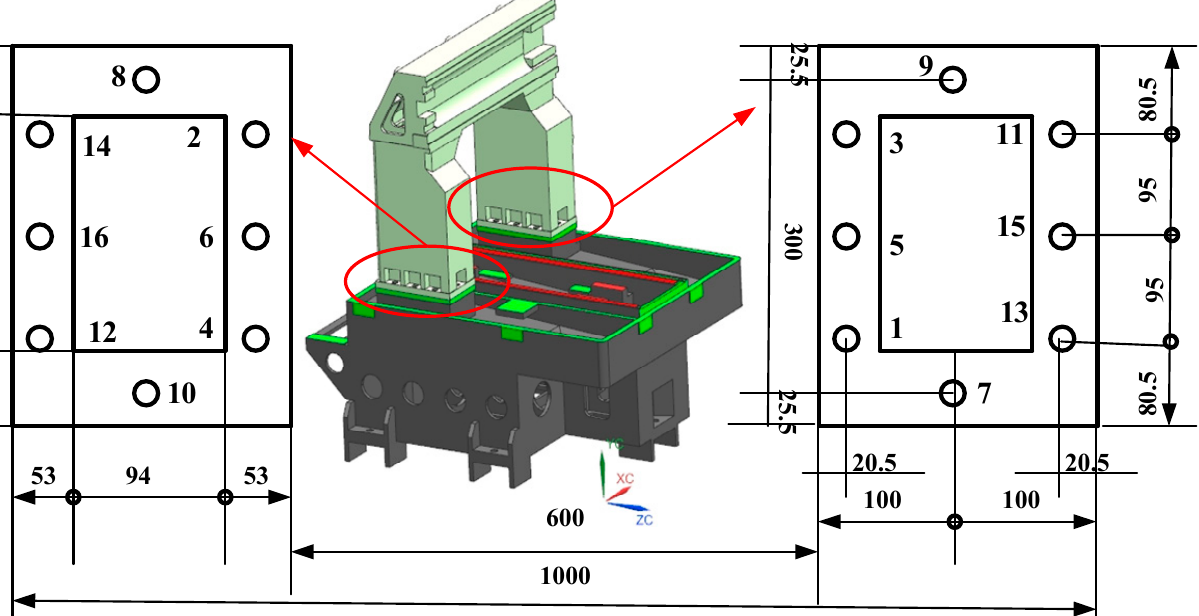
Table 11. Parameters of the transition interface model.